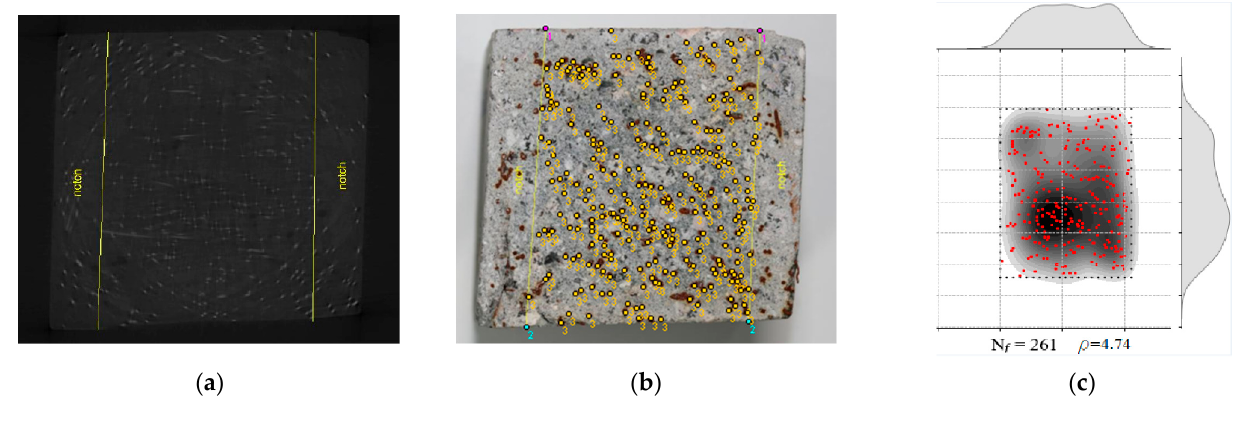
Figure 8. Identification of fibers of a shear cross-section: ( a ) CT image; ( b ) fiber position and counting: labels 1 and 2 are the top and bottom points, respectively, defining the limits of the shear section, and label 3 corresponds to every fiber position ( c ) distribution and density of fibers.